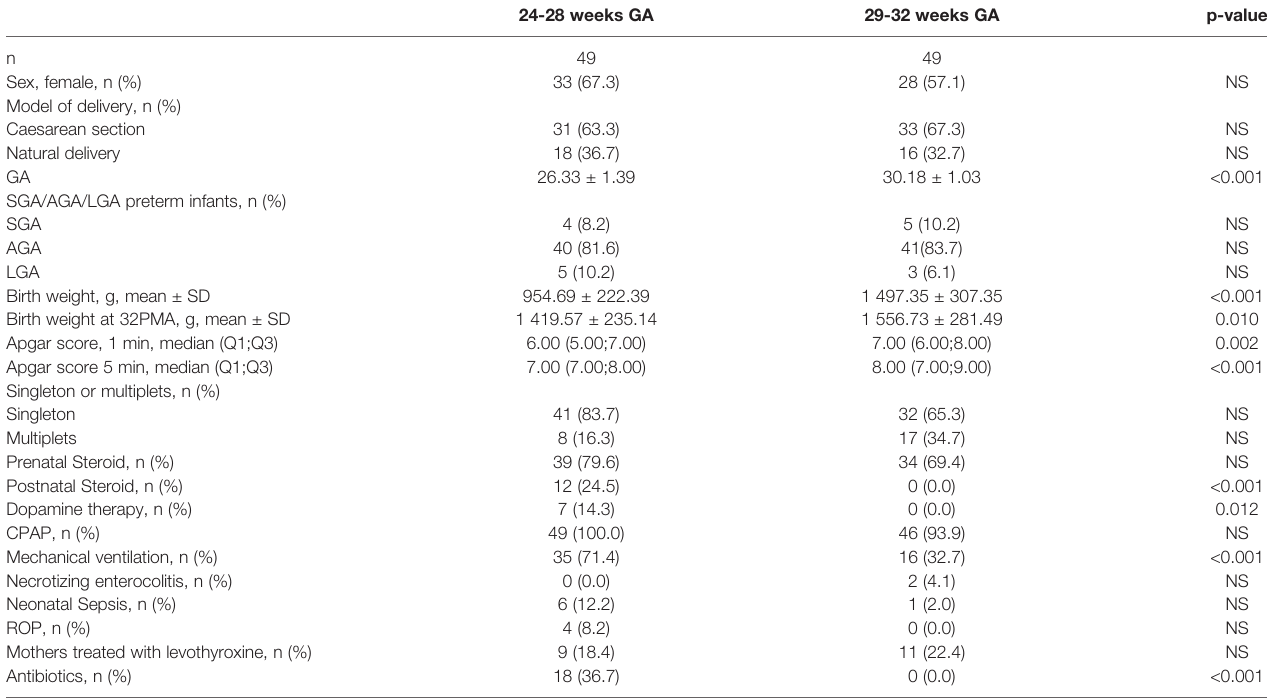
TABLE 1 | Demographic characteristics of the study